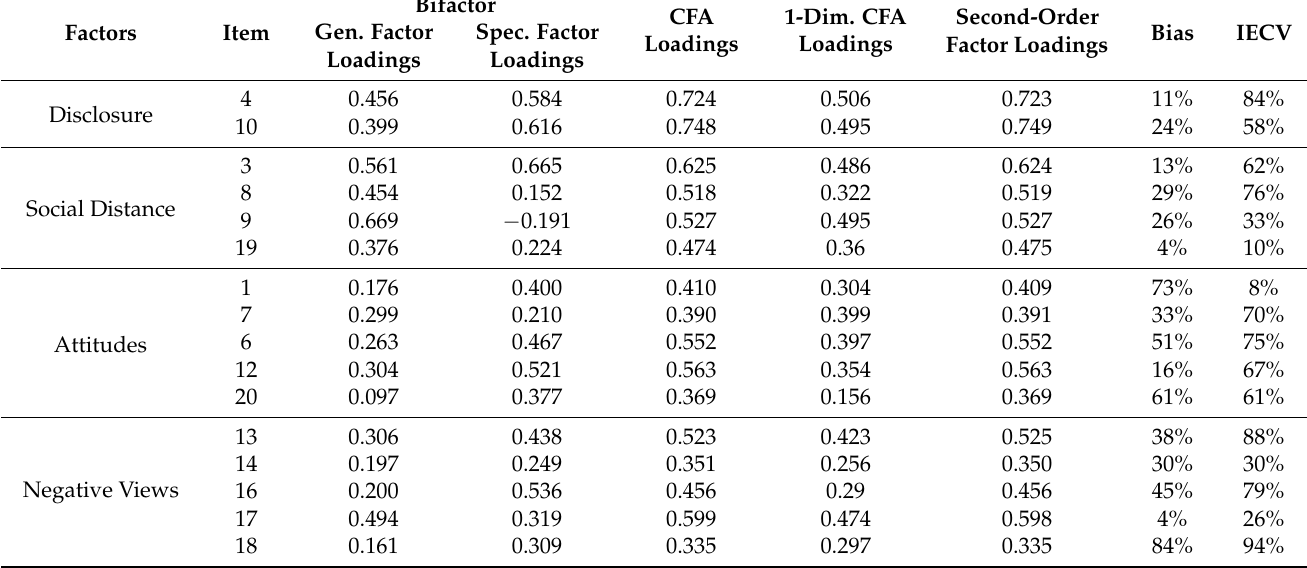
Table 4. Standardized item loadings for each model. Bias = difference in percent between loadings in the general OMS factor from the bifactor model and the CFA with a single factor. IECV = ECV at the item level; percent of the item common variance that is explained by the general